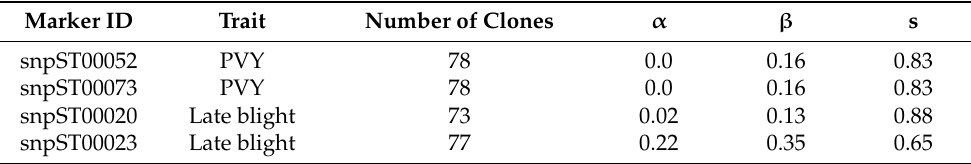
Table 4. Assay verification of the PVY Ryadg (snpST00052 and snpST00073) and late blight (snpST00020 and snpST00023) KASP markers tested on three samples of the CIP breeding program.